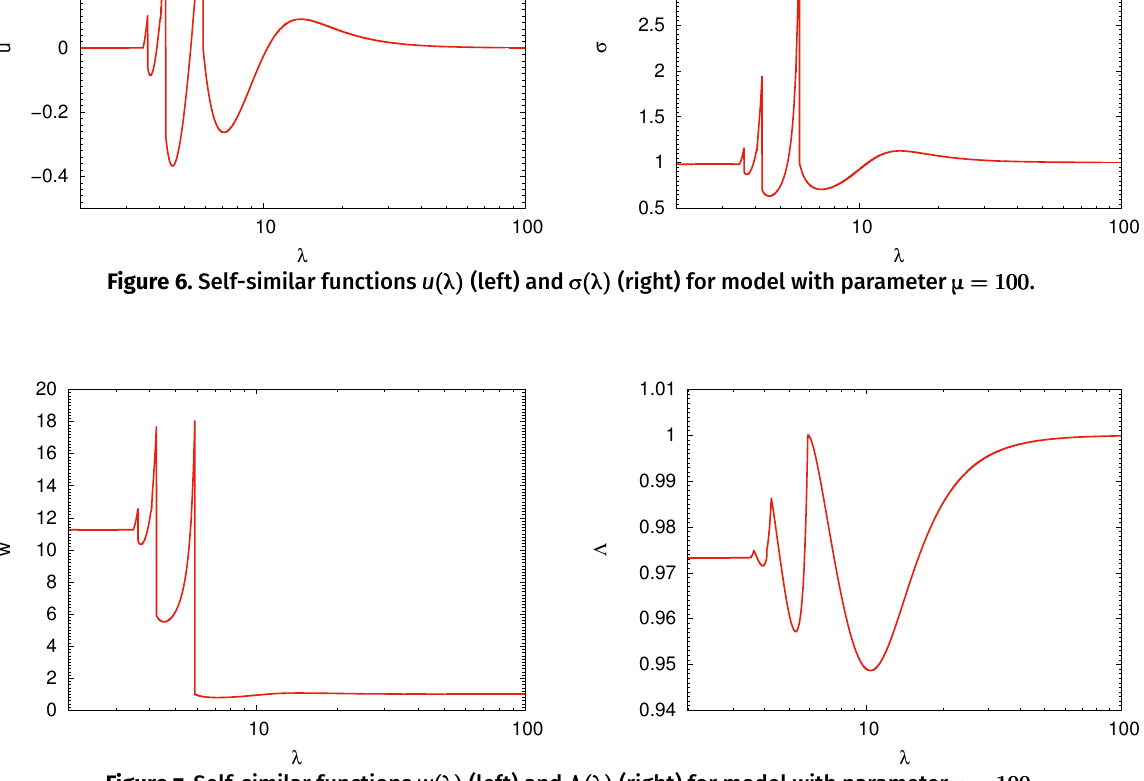
Figure 7. Self-similar functions w ( λ ) w ( λ ) w ( λ ) (left) and Λ( λ )Λ( λ )Λ( λ ) (right) for model with parameter μ = 100 μ = 100 μ = 100 .